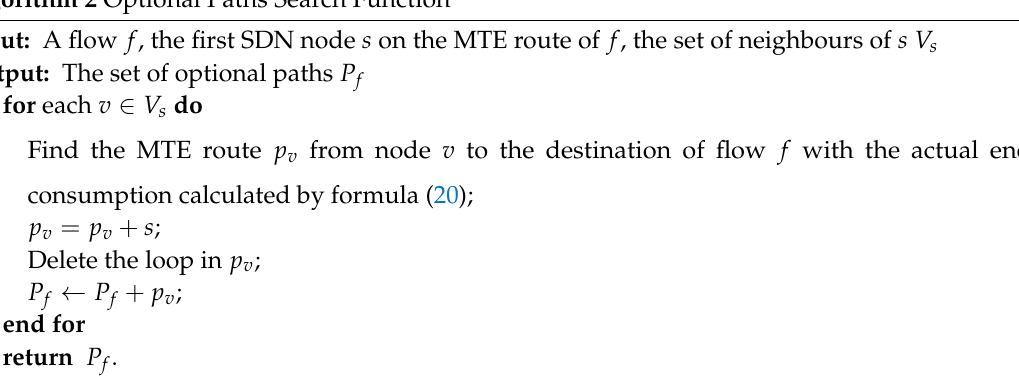
Algorithm 2 Optional Paths Search